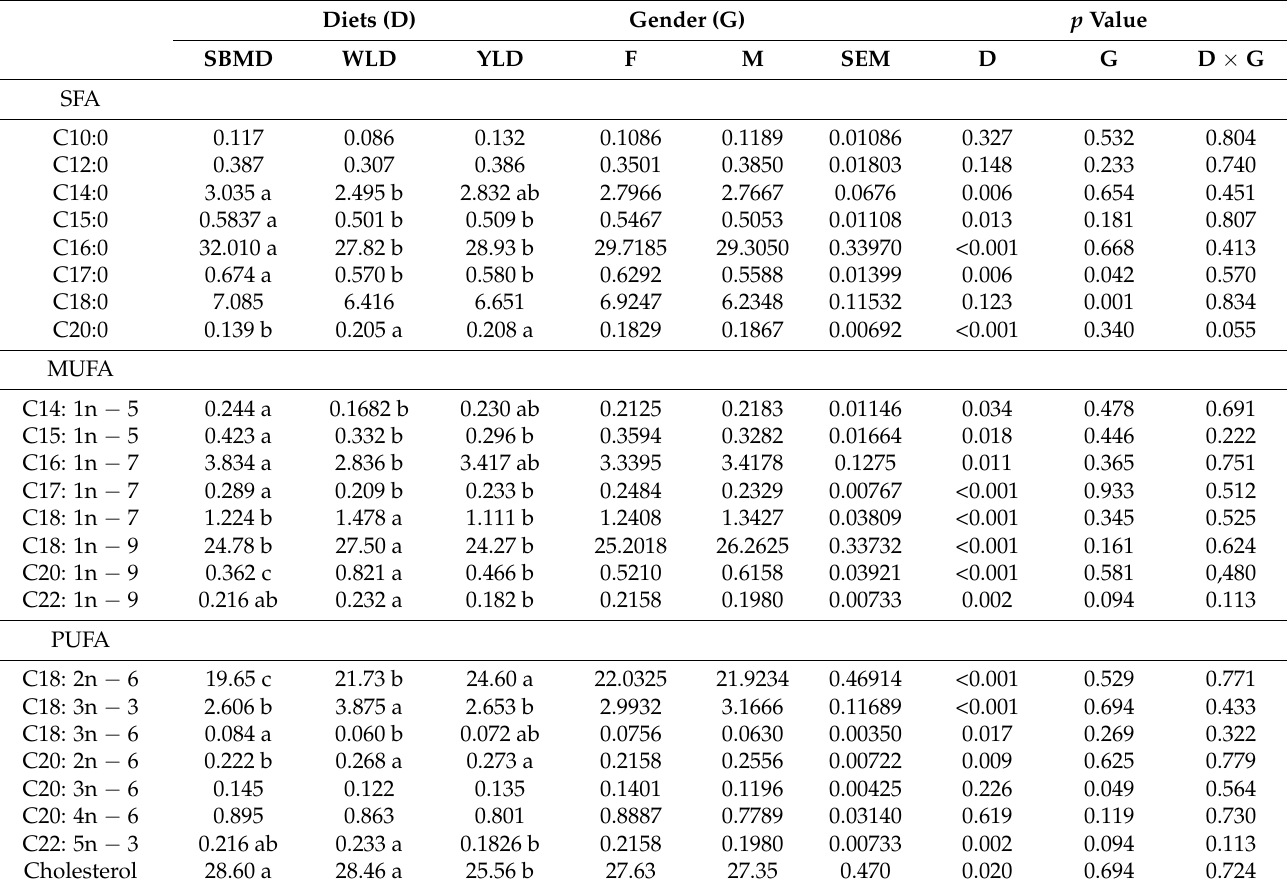
Table 4. Effects of diet and gender on the major fatty acids and cholesterol (g/100 g identified FA) composition of the longissimus dorsi muscle of rabbits at 69 days of age ( n = 10 per